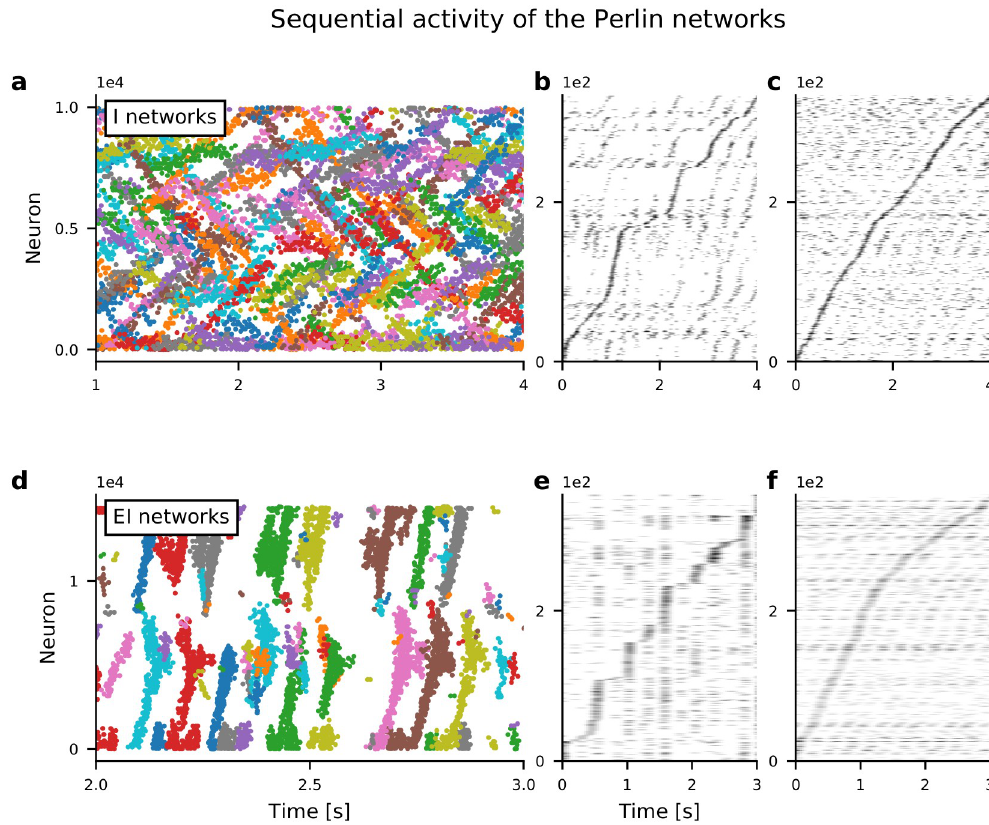
Fig 3. Spatio-temporal sequences of neuronal activity in networks with Perlin configuration. (a) Raster plot of spiking activity in an I-network model as a function of time. Each color indicates a cluster of spiking activity in space and time, identified using DBSCAN (see Methods). Note that spikes that were not assigned to any cluster are not shown. (b) Activity of approx. 250 neurons confined in a 20 × 20 region. (c) Activity of approx. 250 neurons randomly selected from the entire network. (b, c) Selected neurons are sorted according to the time of peaked spike counts. (d, e, f) Same as in panels a, b, c , respectively, but here for an EI-network model. Note the shorter time axes in panels d, e, f , compared to panels a, b, c , indicating that sequence movement in EI-networks was clearly faster than in